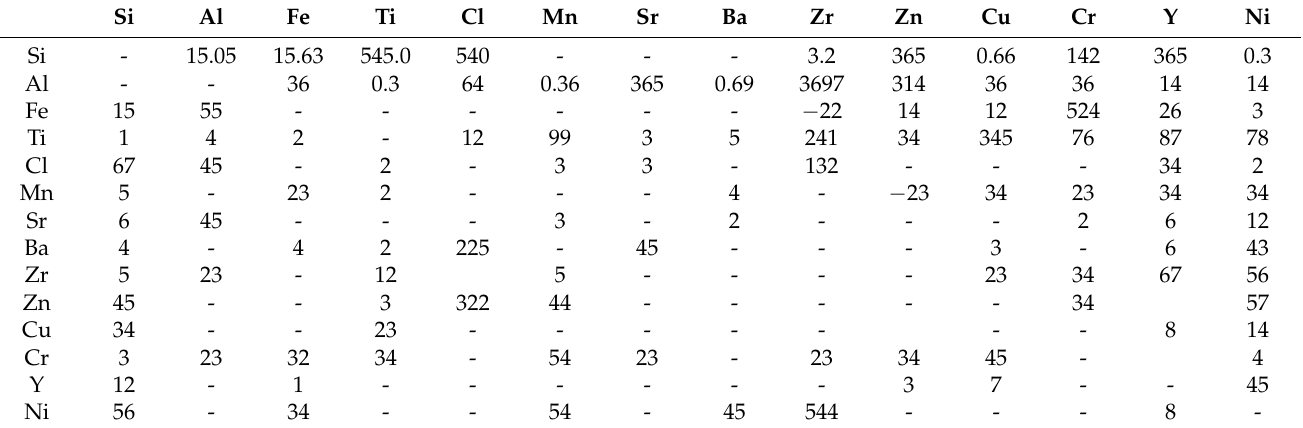
Table 2. Thecoefficientsofmicroelementsthatgeneratetheoptimalpredictionperformanceforeach element.